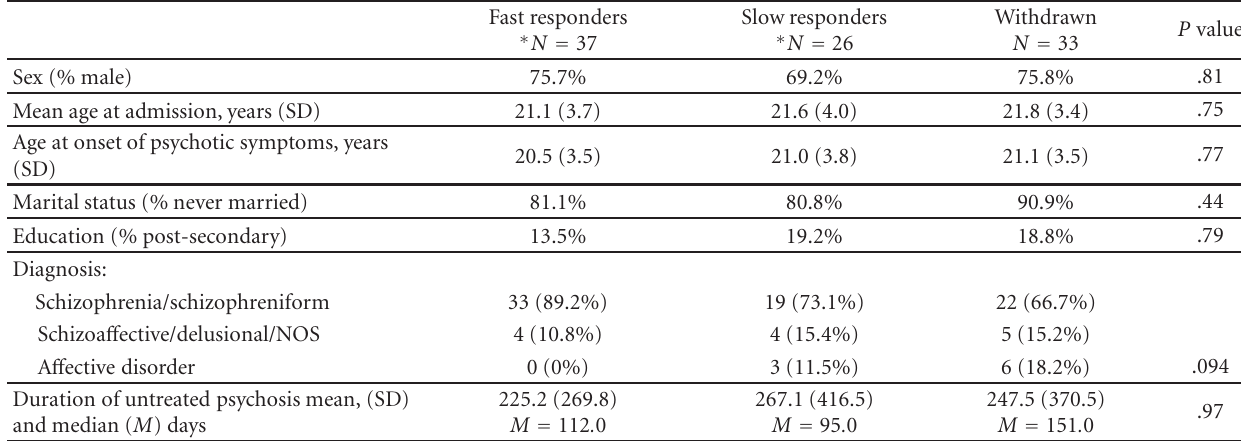
Table 1: Sociodemographic and illness-related characteristics of the participants ( N =